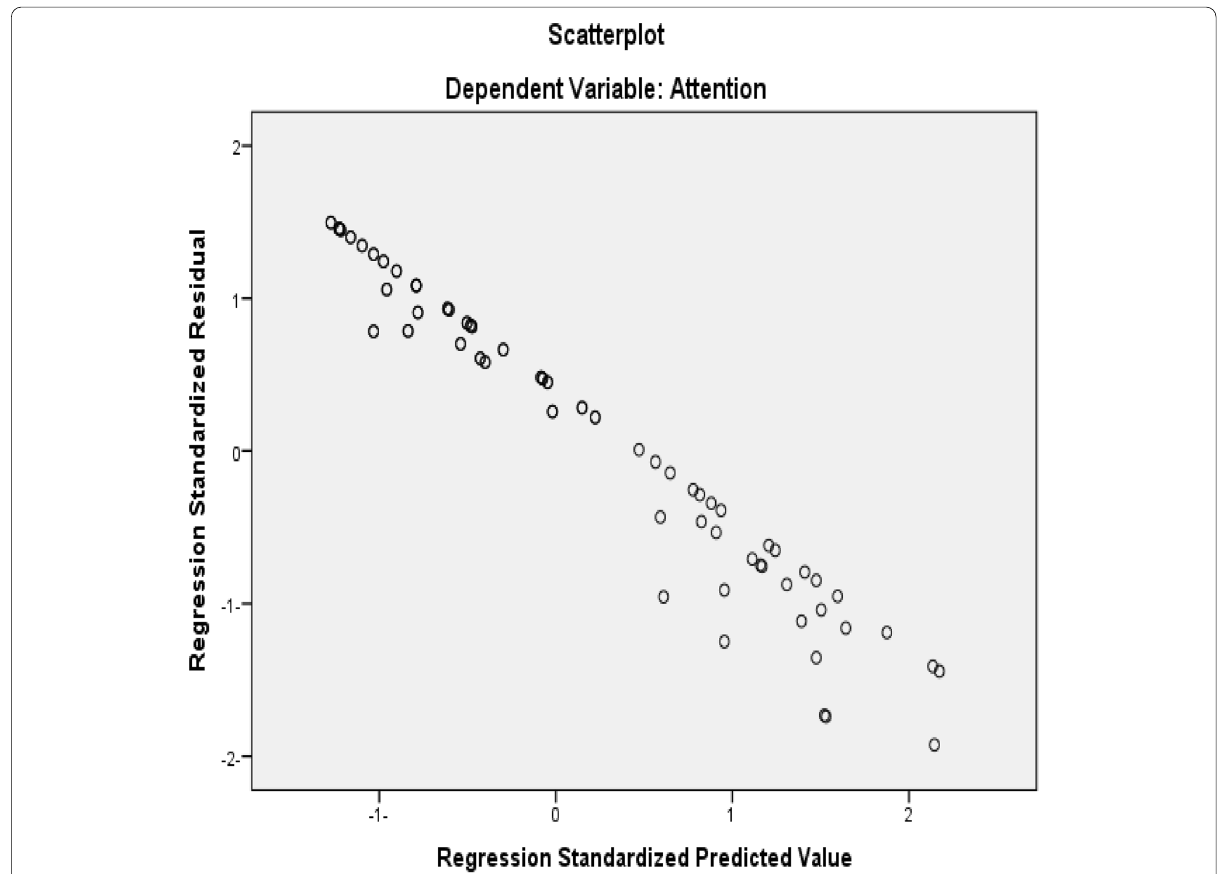
Fig. 4 Scatterplot shows dependent variable: attention; regression standardized residual; regression standardized predicted